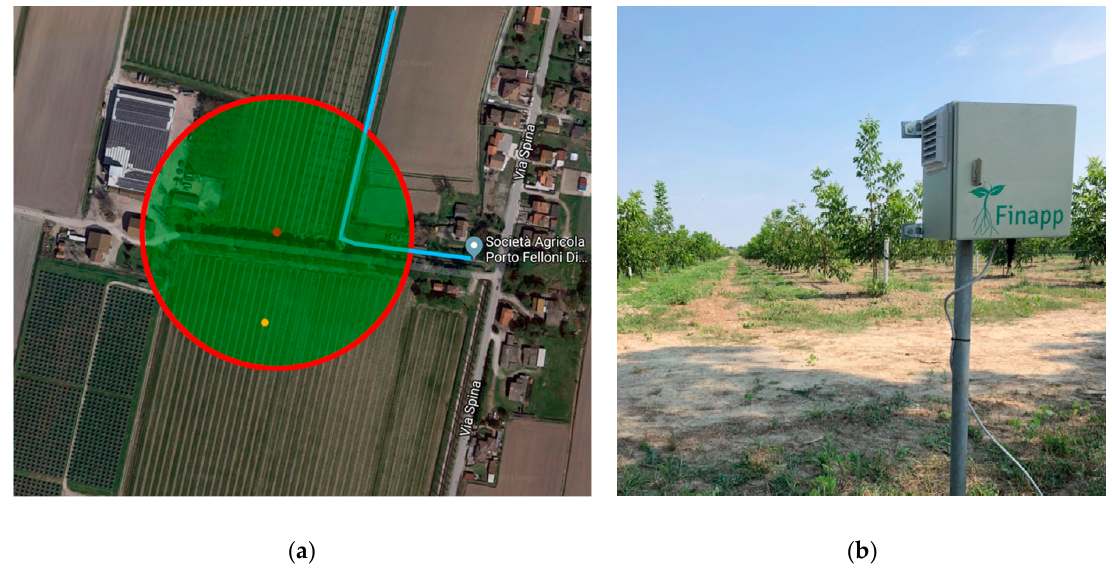
Table 1. Texture of the soil where the Sentek probes were installed. Figure 5. ( a ) Field site, red point is where the Finapp probe was installed, the red circle is the footprint, the orange point represents where the five Sentek probes are installed at di ff erent depths, and the light blue line is the drainage canal. ( b ) Picture of the installation.